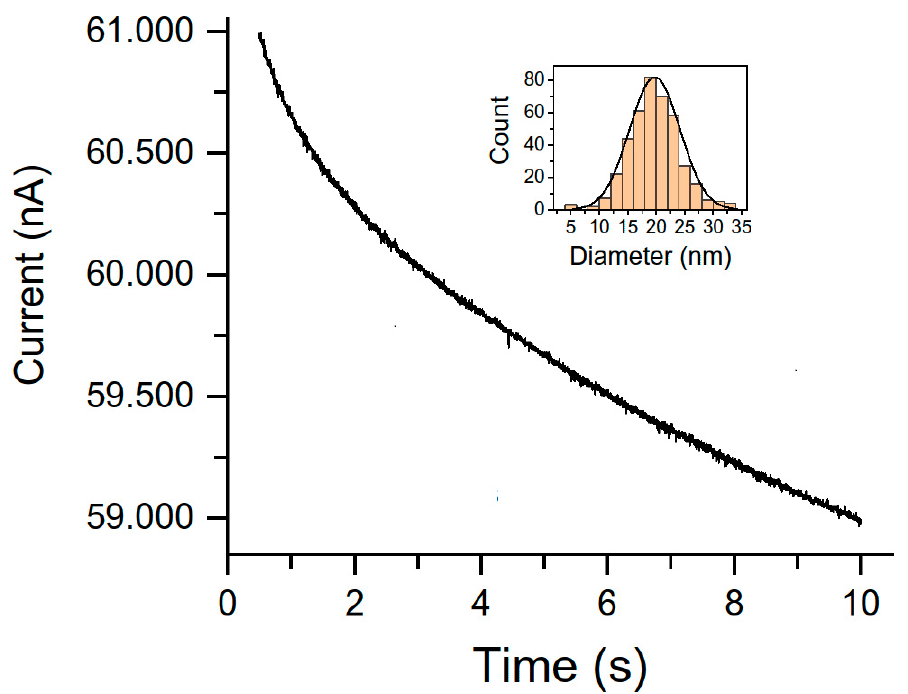
Figure 4. The depiction of a chronoamperogram of a dispersion containing 20 ng L − 1 silver nanopar- ticles with a characteristic diameter of 20 nm in 0.02 mol.dm − 3 NaClO 4 measured at 0.70 V vs. SCE using carbon fiber microelectrode based on the data given in [24]. Inset: AgNPs size distribution calculated from the spikes measured in the time domain from 2 to 10 s.